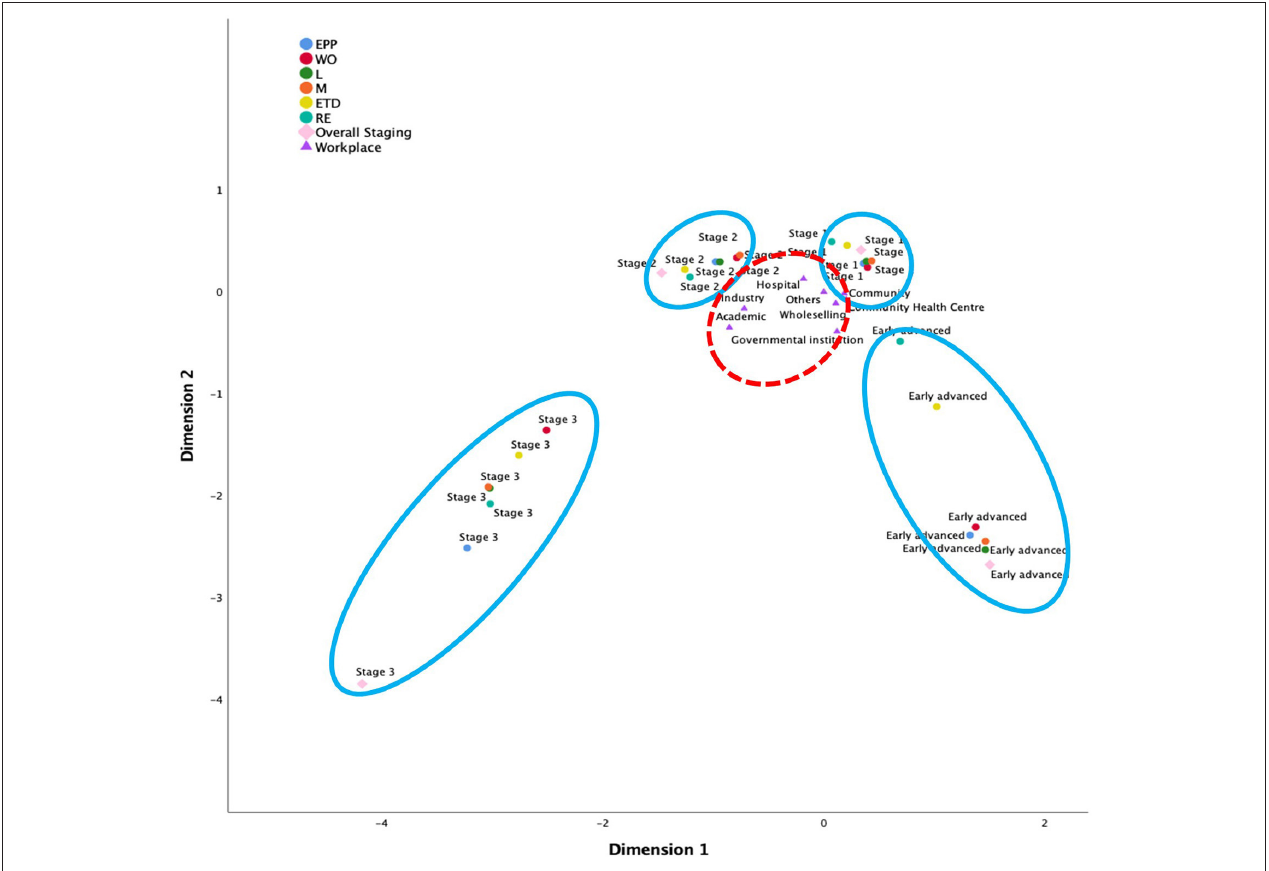
FIGURE 3 | MCA using the four-stage career development pathway model; advancement stages are grouped in blue, workplace groupings are in